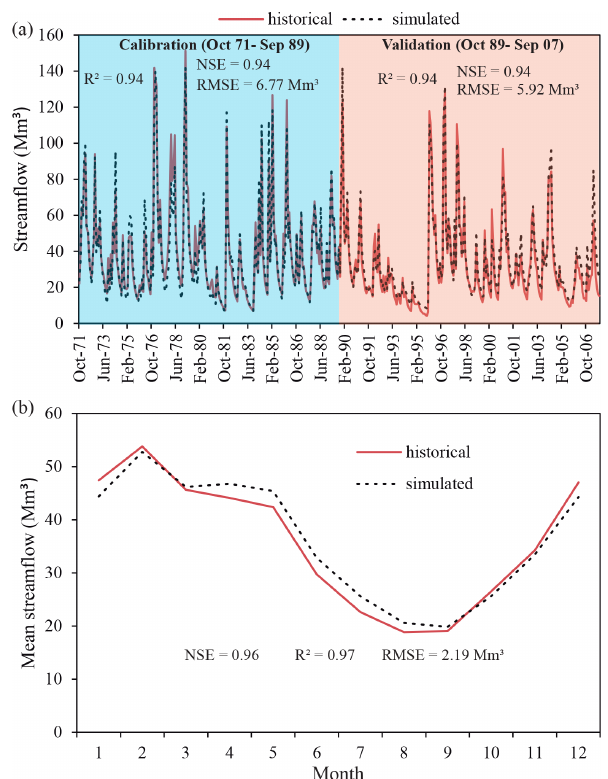
Figure 3. Historical and simulated monthly streamflow series in the Cenajo basin for the calibration period (October 1971 to Septem- ber 1989) and the validation period (October 1989 to Septem- ber 2007) (a) and mean monthly values within the mean year of the entire period (October 1971 to September 2007) (b) .